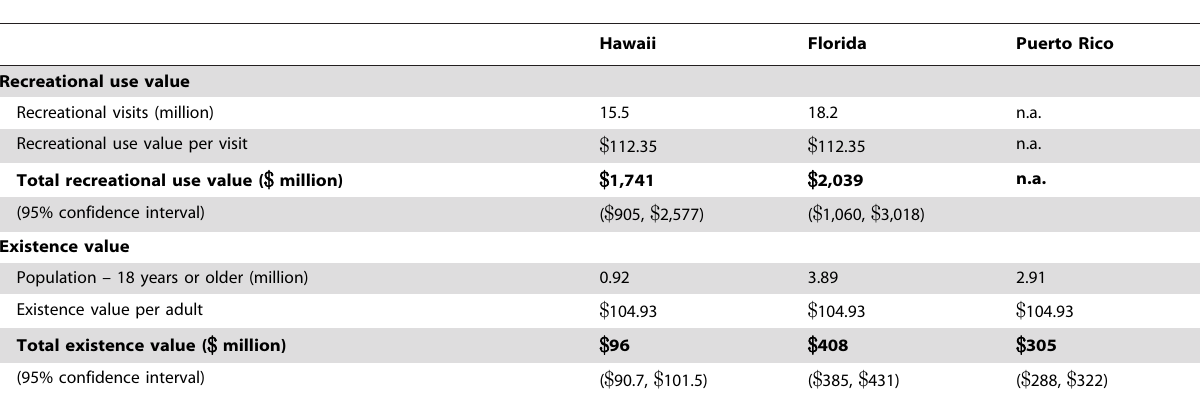
Sources: Recreational visits – Hawaii: Table 8.1 in Cesar et al. [26]. Florida: Table ES-5, natural reefs only, in Johns et al. [27]. Puerto Rico: estimates of total recreational use unavailable. Recreational use value per visit – Average of seven studies conducted in Florida, Hawaii, Puerto Rico, and the Gulf of Mexico (see Table 2). Number of adults – Hawaii: 2010 census. Florida: 2010 census (includes only Broward, Miami-Dade, Monroe, and Palm Beach counties). Puerto Rico: Adult population from p. 83 in Estudios Te´cnicos [28]. Existence value per person – Table 2, existence value, in Estudios Te´cnicos